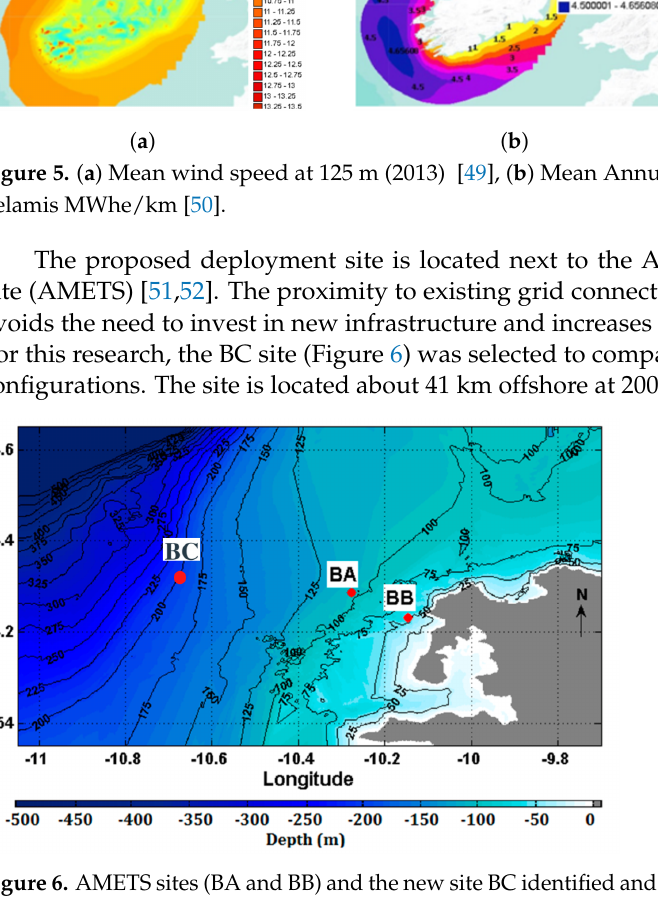
Figure 6. AMETS sites (BA and BB) and the new site BC identified and considered in this work [51,53].